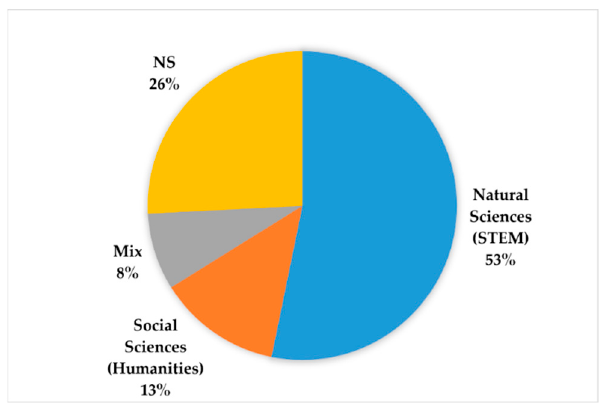
Figure 7. Discipline of academic performance predictions using learning outcomes.